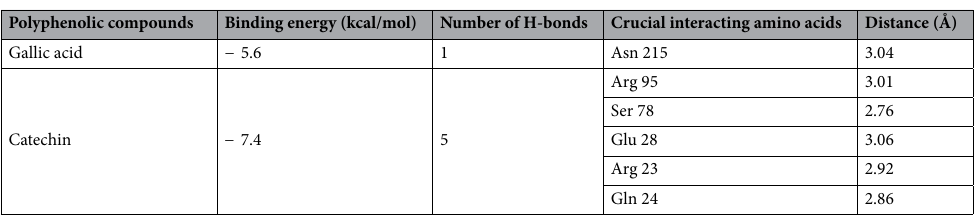
Table 4. Summary of docking analysis of AQP-3 protein with gallic acid and catechin from AutoDock Vina tool.